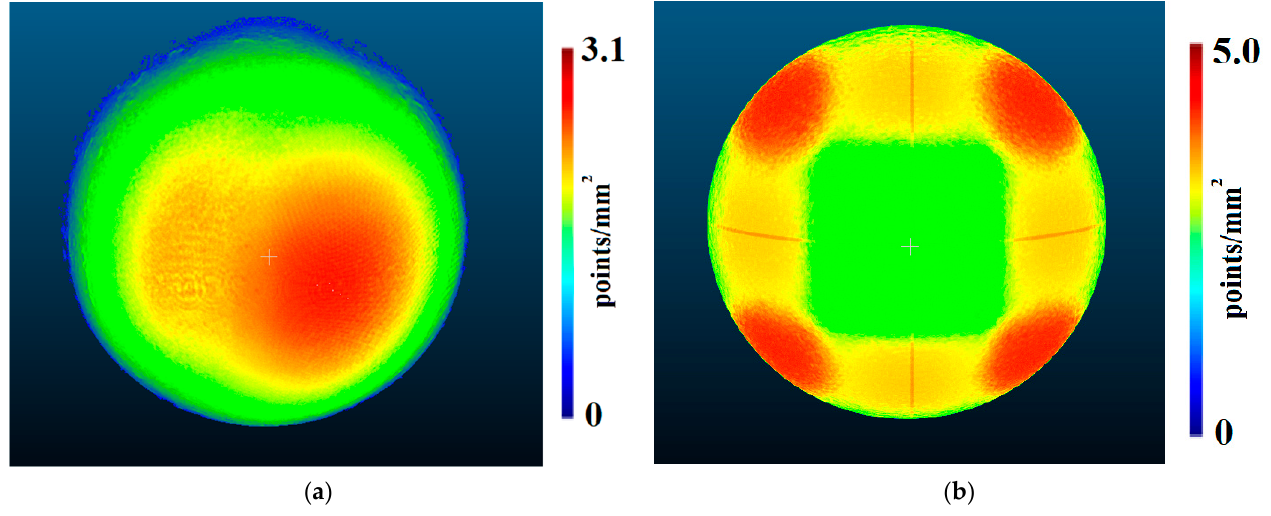
Figure 21. The differences in the point distribution obtained by the ( a ) OpenMVS—Patch-Based Stereo Method; and ( b ) Agisoft Metashape—Semi-Global Matching from the same synthetic images.